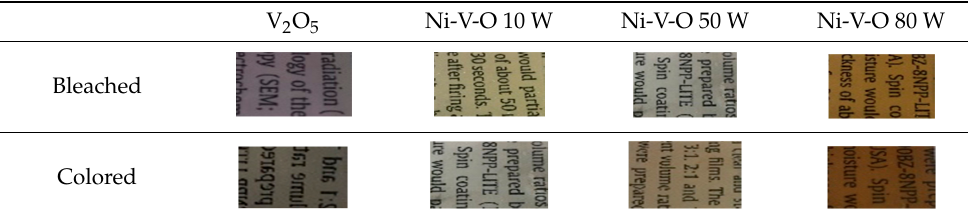
Table 3. The photographs of colored and bleached states of the V 2 O 5 thin film and the Ni-V-O thin